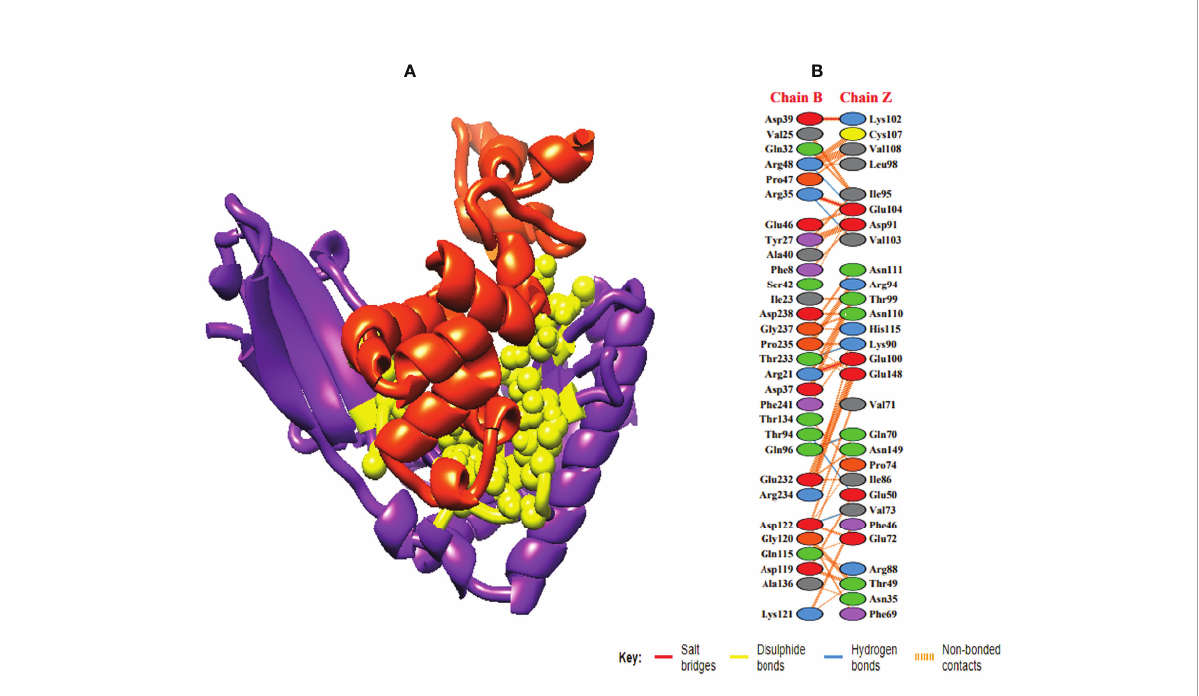
FIGURE 5 Schematic illustration of MEMPV-MHC I docked cluster. (A) Docked pose of MEMPV-MHC I docked cluster. Construct in orange-red, MHC I receptor in purple and interacting residues between immune receptor and vaccine are shown in yellow color. (B) Dimplot of vaccine construct- MHC II docked complex.